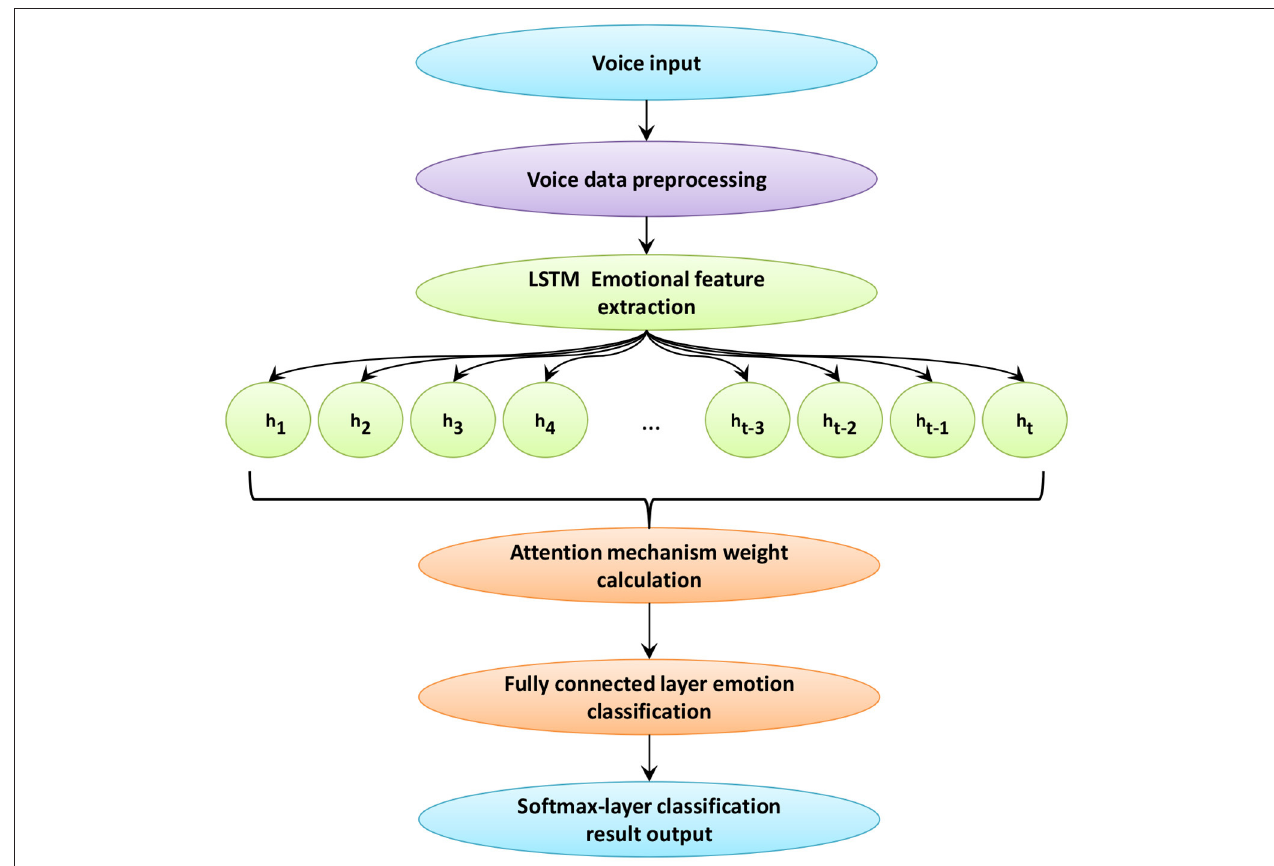
FIGURE 3 | Speech recognition framework based on the method in this